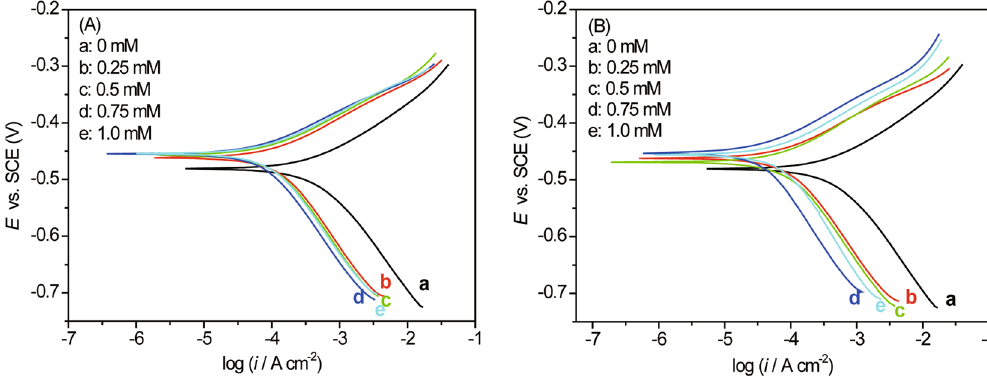
Figure 5. Potentiodynamic polarization (PDP) plots for carbon steel in 0.5 M HCl solution at a scan rate of 0.5 mV s − 1 without/with different concentrations of BAIL1 ( A ) and BAIL2 ( B ).